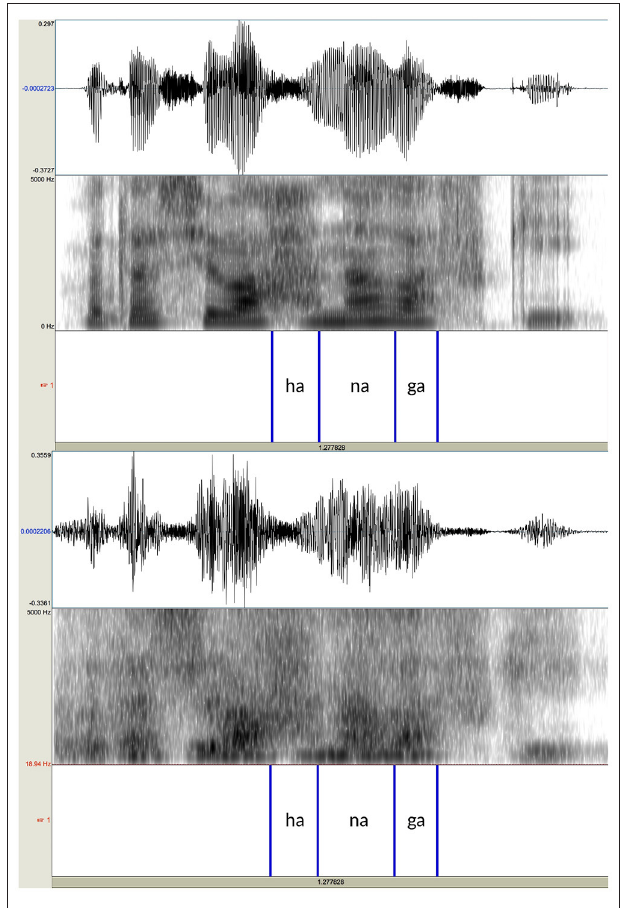
FIGURE 3 | Waveforms and spectrograms of the sentence /watasi wa han´a ga suk´ı/ ‘I prefer flowers’ produced by the female speaker (upper panel) and its noise-vocoded version with the bandwidth of 2 ERB N (lower panel). The annotations at the bottom of each panel indicate the locations of the test words and their following